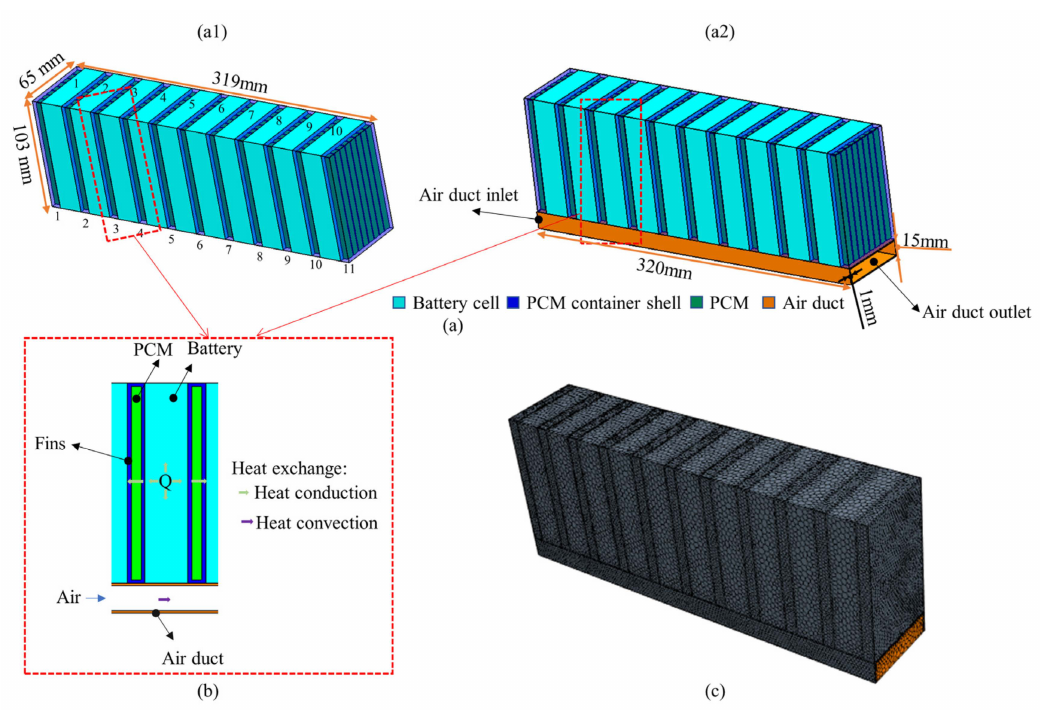
Figure 5. ( a ) battery module: ( a1 ) battery module without air-forced cooling, The upper num- ber represents the battery serial number, the lower number represents the PCM container serial number. ( a2 ) battery module with air-forced cooling; ( b ) heat transfer analysis model; ( c ) battery module